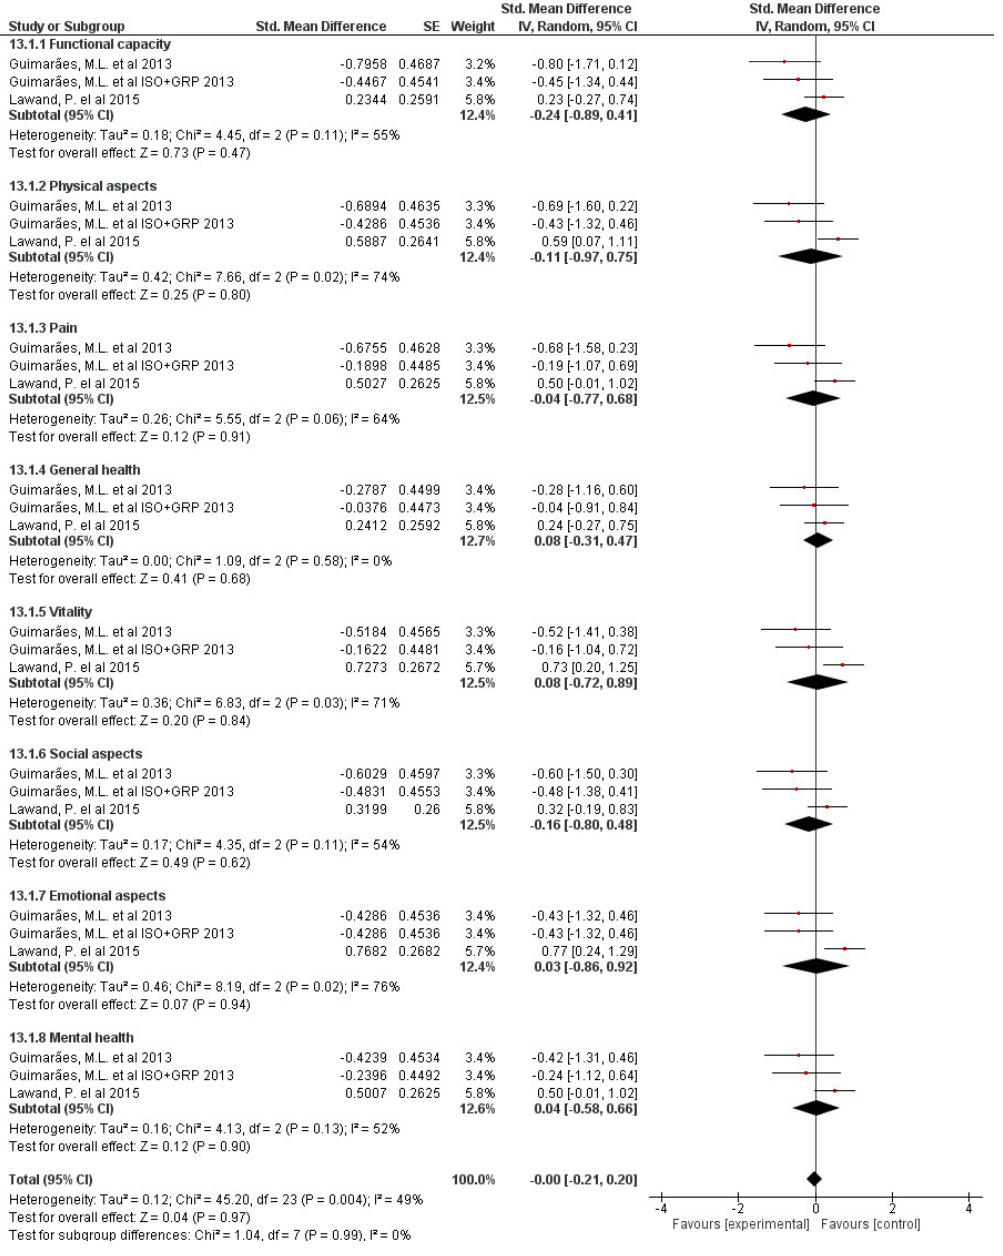
Figure 4. Effects of GPR on quality of life.